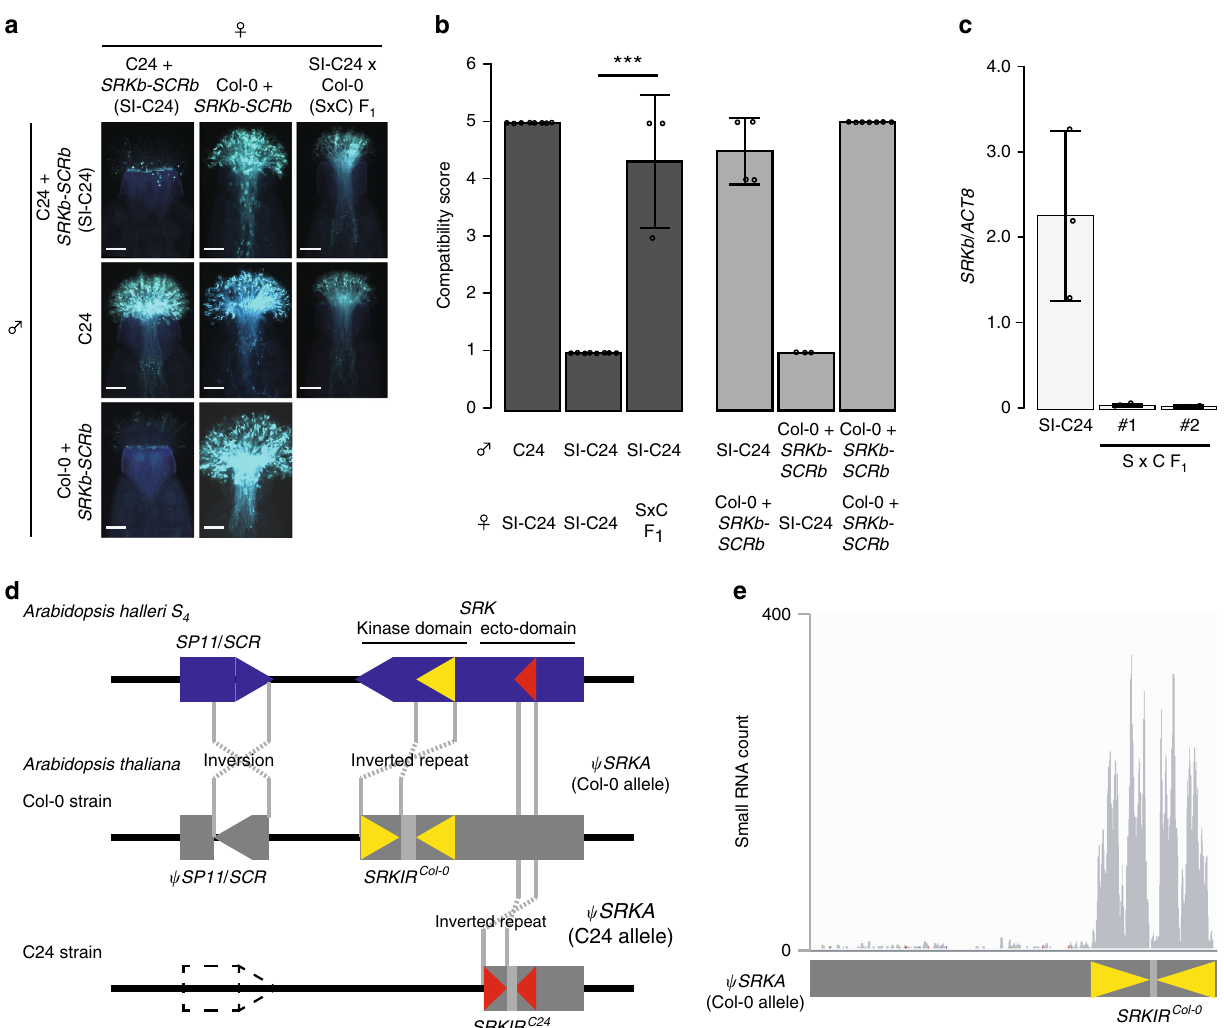
Fig. 1 SRKb mRNA expression in the Col-0 × SI-C24 F 1 hybrids and accumulation of small RNAs derived from SRKIR Col-0 . a Representative fl uorescent images of aniline blue-stained pistils at stage 14 three hours after pollination. Scale bars = 100 µ m. b Summary of pollination tests. S × C F 1 is the hybrid obtained from the cross: ♀ SI-C24 × ♂ Col-0. Compatibility phenotypes were scored as described in the methods. Statistically signi fi cant differences based on Dunnett ’ s test are indicated by ***( p < 0.005), with the exact p -value being 7.16e − 06. Error bars indicate standard deviations. The number of pistils pollinated (from left to right): n = 8, n = 8, n = 8, n = 4, n = 3, n = 7. c Relative mRNA accumulation levels of SRKb compared to ACTIN8 ( ACT8 ) in stigmatic tissues of the indicated lines. Two independent S × C F 1 individuals (#1 and #2) were analyzed. Error bars indicate standard deviations from independent RNA extraction trials ( n = 3). d Illustration comparing the S loci of A. thaliana Col-0 and C24, and the A. halleri S 4 haplotype. Col-0 carries an inverted repeat with homology to the sequence encoding the kinase domain of SRK. The C24 strain carries an inverted repeat with homology to the sequence encoding the ecto-domain of SRK. e A histogram showing the numbers of small RNAs from stigmas that map to the pseudogenized SRKA gene ( ψ SRKA ) of Col-0; most small RNAs map to the inverted repeat region (see Supplementary Fig. 2a for the mapping results for the fl anking